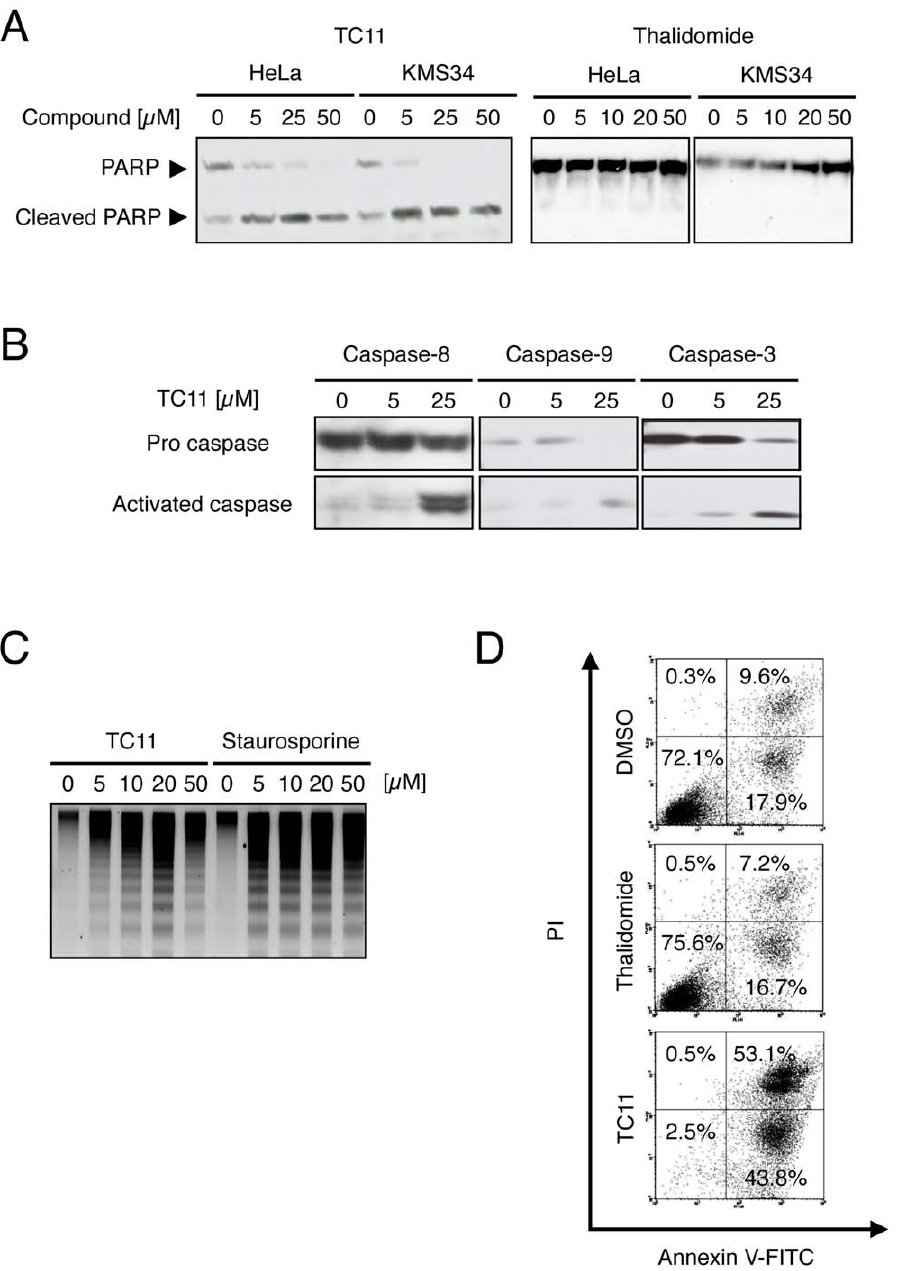
Figure 2. TC11 induces apoptosis of multiple myeloma cells in a caspase-dependent manner. (A) HeLa or KMS34 cells were treated with 0–50 m M TC11 or thalidomide for 24 h. The whole cell lysates were analyzed by Western blotting with anti-PARP antibody. (B) KMS34 cells were treated with 0, 5 or 25 m M TC11 for 6 h. The whole cell lysates were analyzed by Western blotting with anti-caspase-3, 8 or 9 antibody, respectively. (C) KMS34 cells were treated with 0–50 m M TC11 or staurosporin A for 6 h. After DNA extraction, 1% agarose gel electrophoresis was performed. (D) KMS34 cells were treated with 50 m M thalidomide or TC11. After 96 h, cells were stained with FITC-coupled annexin V and propidium iodide, and induction of apoptosis was evaluated by flow cytometry.